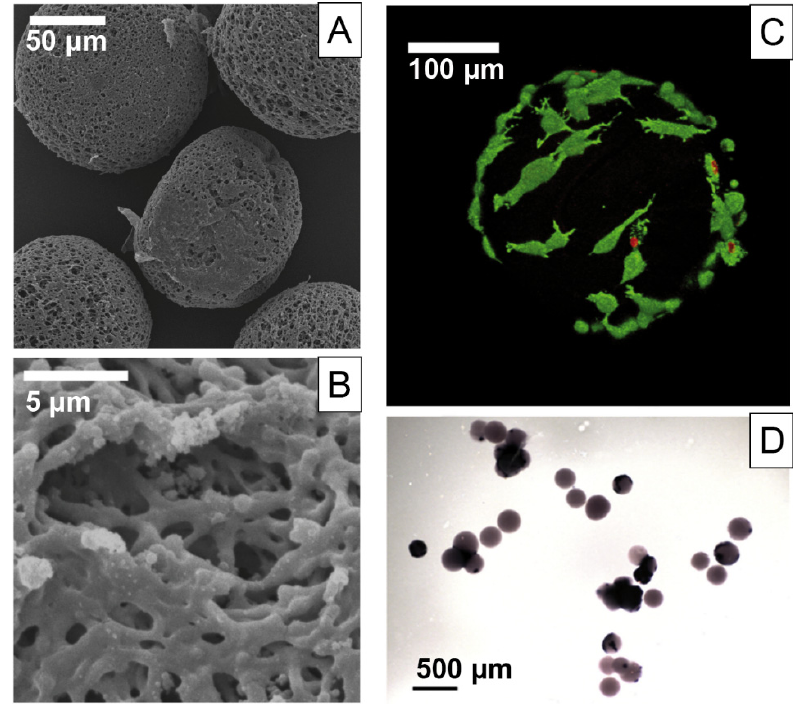
Figure 6. ( A ) Scanning electron microscopy images of blend hydrogel microcarriers using Bombyx mori silk fibroin and porcine gelatine at a 3:1 ratio and asymmetric flow focusing in a microfluidic preparation method and ( B ) surface micro-topography at higher magnification. ( C ) Rat mesenchymal stem cells on hydrogel microcarriers visualized using confocal microscopy after 96 h in live/dead staining (dead cells in red, living cells in green) and ( D ) after 28 days. Purple coloring indicates alkaline phosphatase activity of differentiated osteoblasts. Reprinted and adopted with permission from ref. [134]. Copyright 2020 Elsevier.